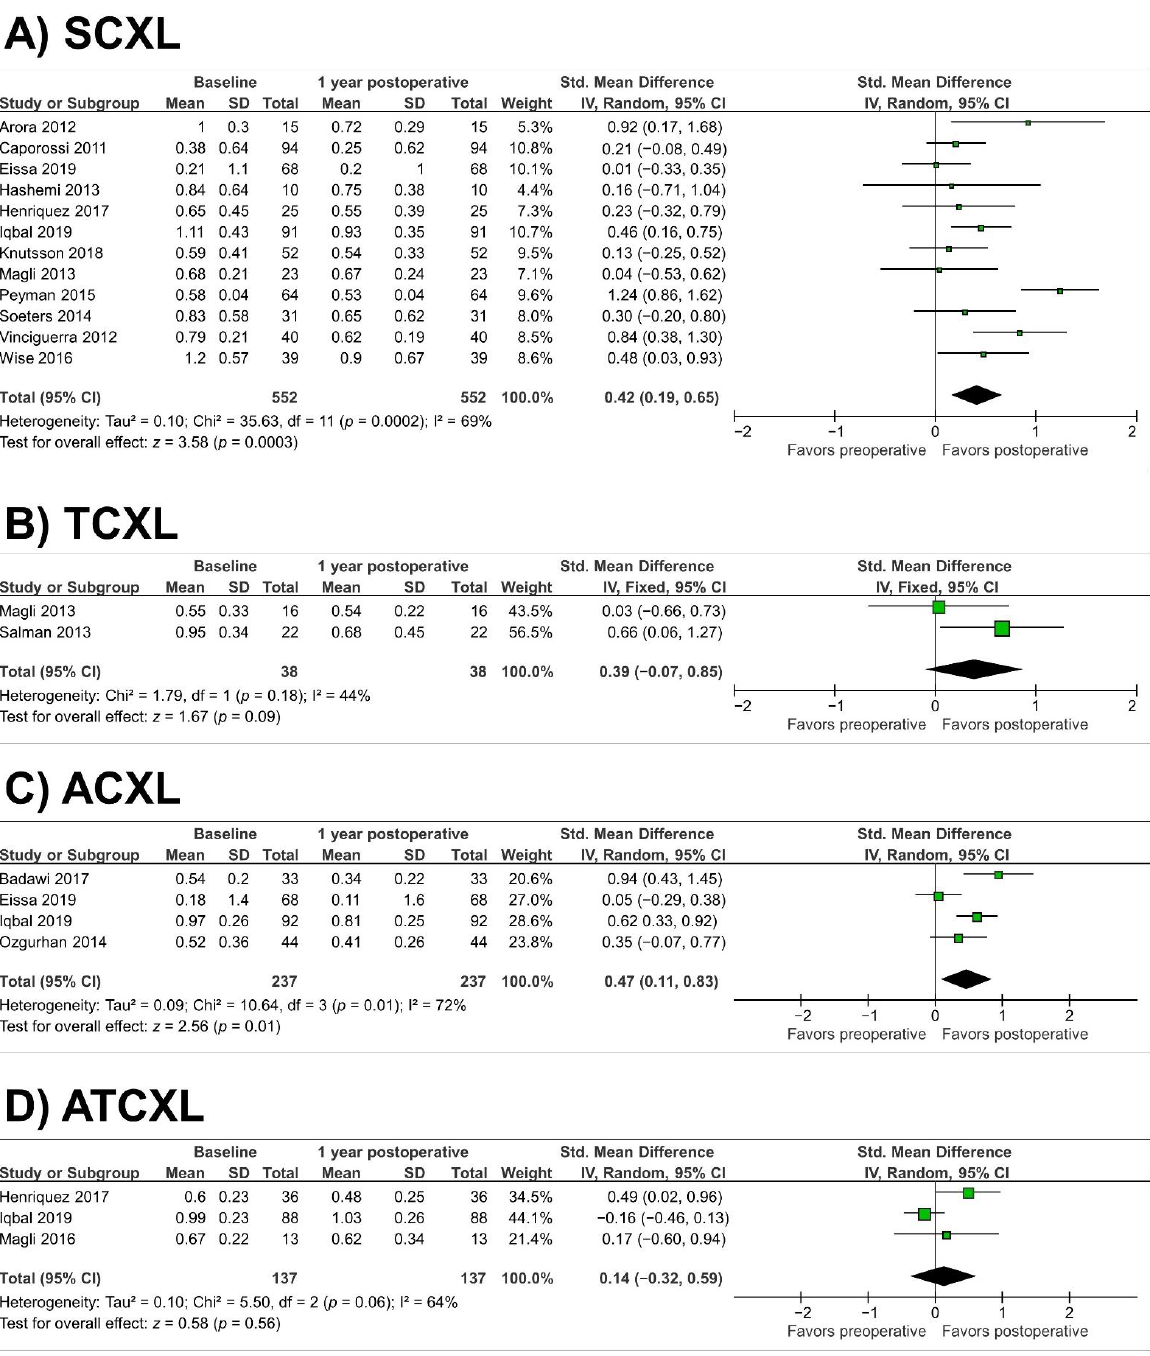
Figure 4. Forest plot of uncorrected visual acuity 1-year standardized mean differences in logMAR in studies included in meta-analysis. ( A ), standard cross-linking (SCXL); ( B ), accelerated CXL (ACXL); ( C ), transepithelial CXL (TCXL), ( D ), accelerated and transepithelial CXL (ATCXL). IV = inverse variance, CI = confidence interval, Tau 2 = tau-square statistic, Chi 2 = chi-square statistic, df = degrees of freedom, I 2 = I-square heterogeneity statistic, z = Z-statistic.